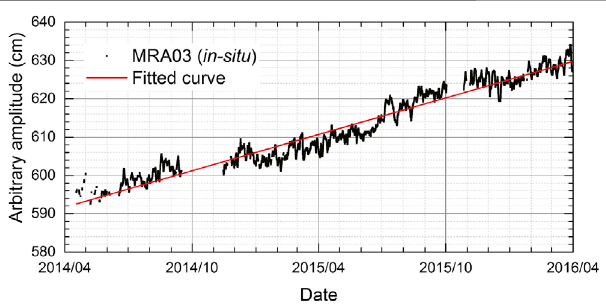
FIGURE 9 | In-situ measurement after tidal correction of MRA03. The fi tted curve derived from Eq. 1 is plotted as a red line.